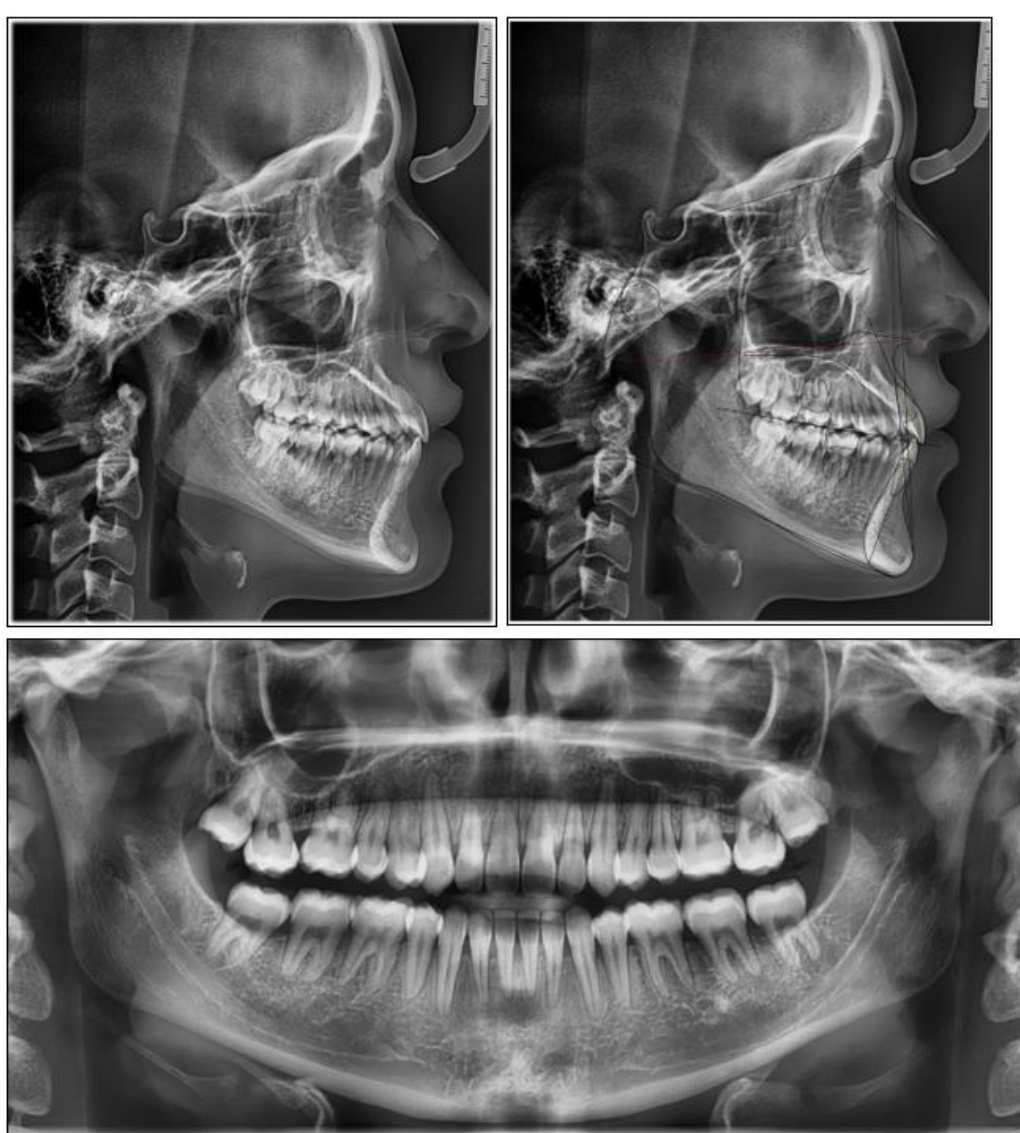
Figure 7. Final radiographs. Figure 8. Final